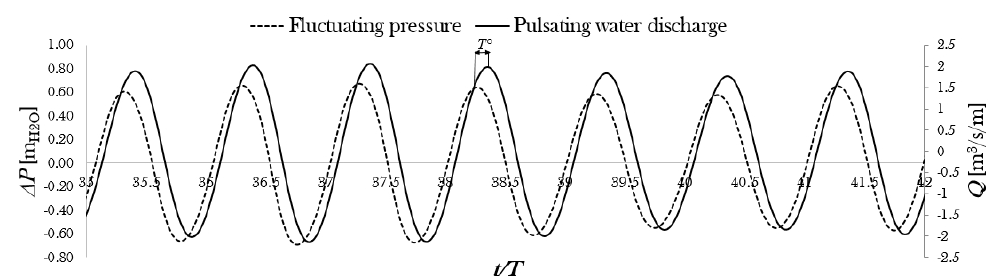
Figure 14. Pressure fluctuation ∆ p at the outer opening and discharge Q in the plant, as a function of t / T [The Q is positive if it enters the plant.] ( H = 1.4 m, T = 6 s).